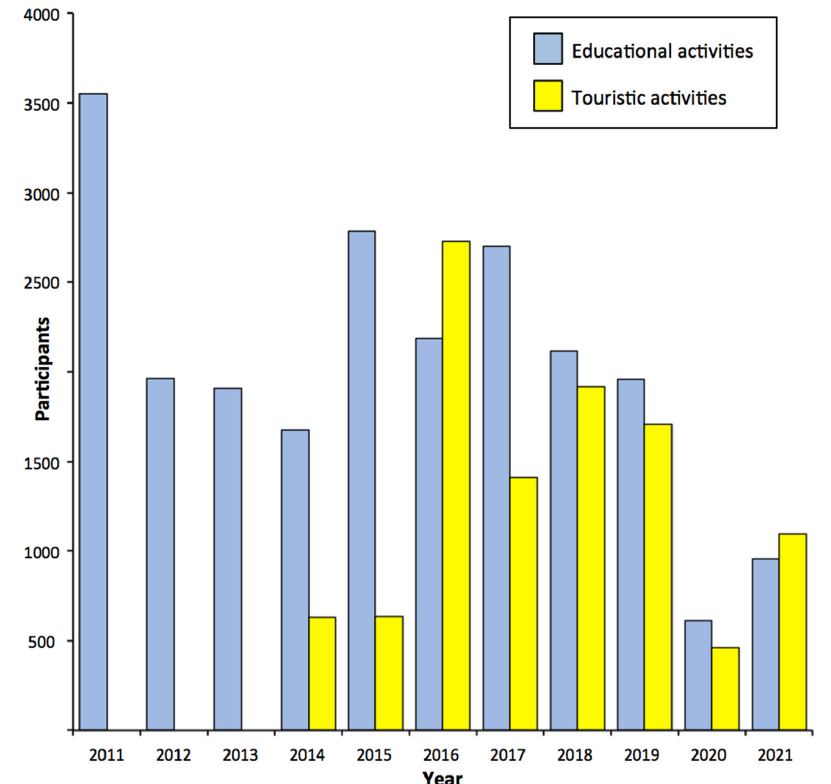
Figure 7. Number of participants in official activities organized by Beigua UGGp from 2011 to 2021. Data of participants in tourism activities from 2011 to 2013 are not available.